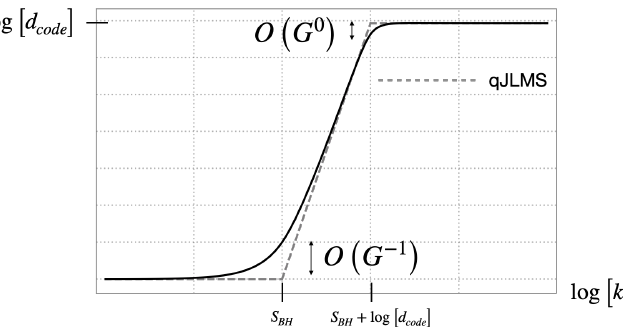
an incompressible state. The large code